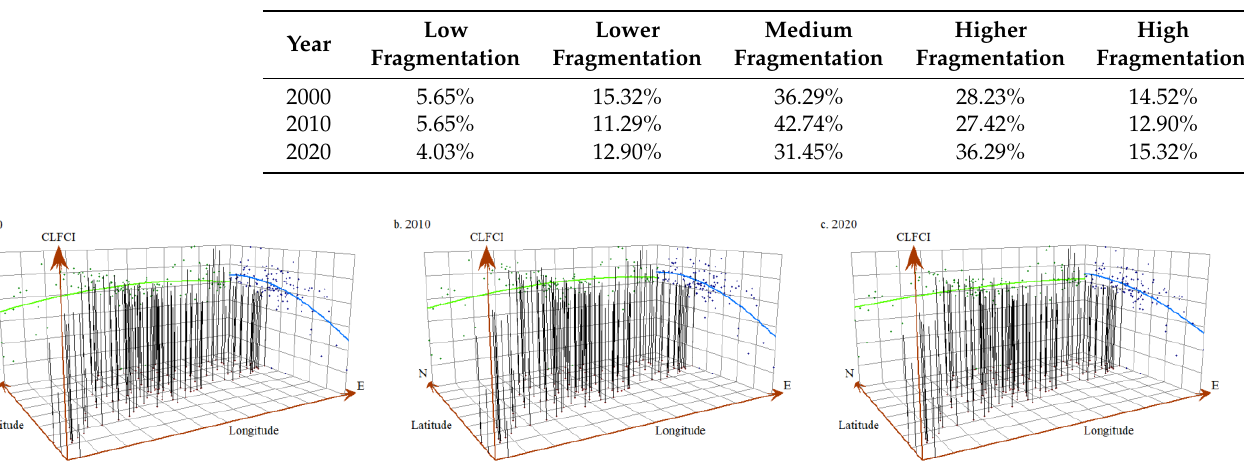
Table 4. Proportion of the number of counties of each CLF grade in Guangdong Province in 2000,